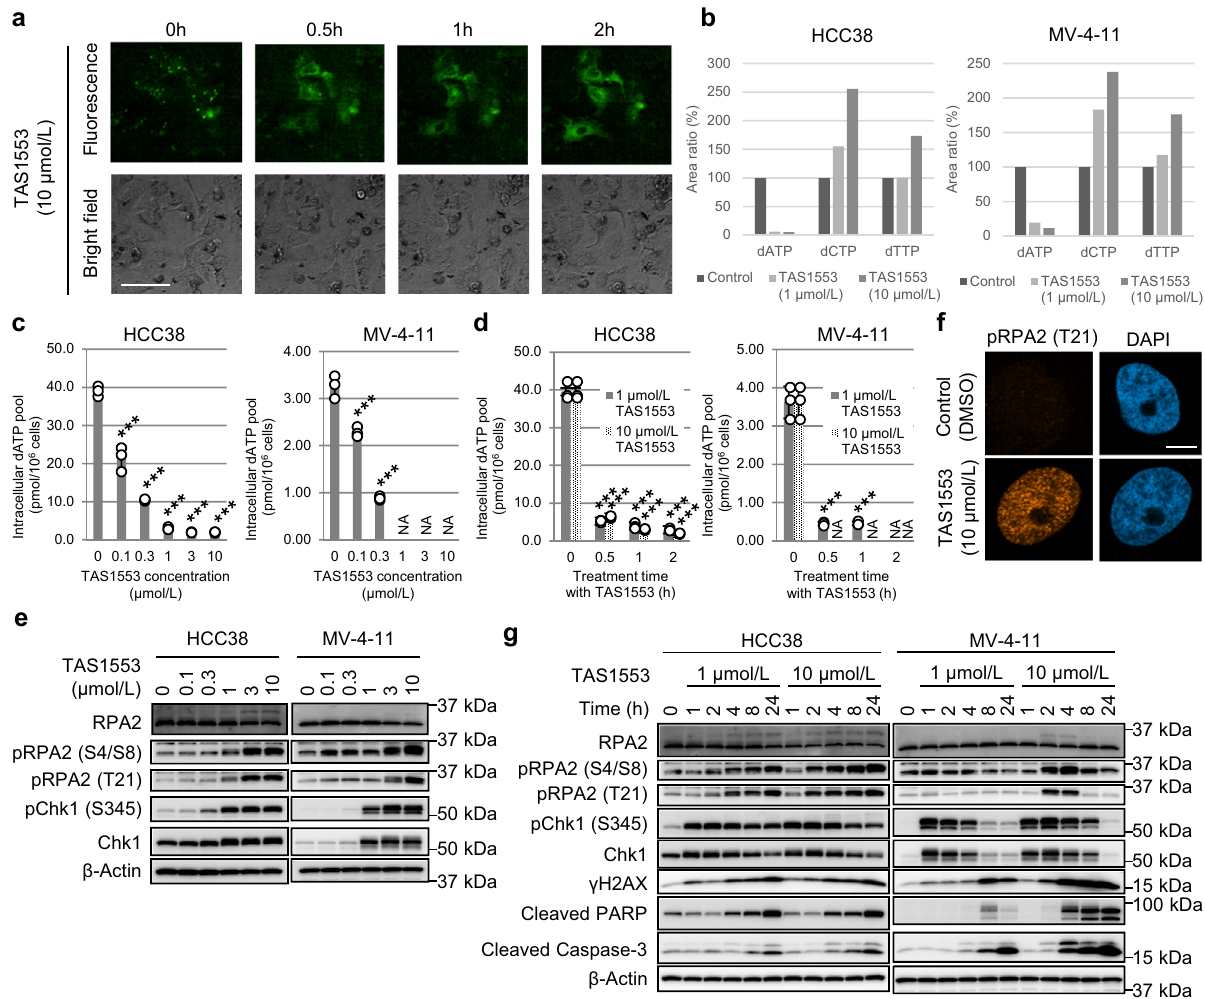
Fig. 2 Effect of TAS1553 on RNR subunit interaction, dNTP pool, DNA replication stress, and apoptosis. a Inhibition of intracellular protein-protein interaction between R1 and R2 by TAS1553. HCC38 cells co-transfected with cDNAs encoding AG-tagged R1 and Ash-tagged R2 were treated with TAS1553 for 2 h, followed by incubation with drug-free medium for 1 h. Fluorescence and bright- fi eld images were obtained at the indicated timepoints. R1- R2 interaction is visible as green dots in fl uorescence images. Scale bar, 100 µ m. b Effect of TAS1553 on intracellular dNTP pool in HCC38 and MV-4-11 cells. Relative changes of dATP, dCTP, and dTTP peak area in HCC38 and MV-4-11 cells treated with TAS1553 for 2 h or DMSO as control. Intracellular metabolites were measured by LC-MS/MS. c Concentration-dependent changes of the dATP pool in HCC38 cells and MV-4-11 cells treated with TAS1553 for 2 h. d Time-dependent changes of the dATP pool in HCC38 cells and MV-4-11 cells treated with TAS1553. Data are presented as the mean ± SD ( N = 3). NA not applicable. *** P < 0.001 versus control (0 µ mol/L or 0 h). e Induction of DNA replication stress and apoptosis by TAS1553 in HCC38 and MV-4-11 cells. Concentration-dependent effect of TAS1553 on DNA replication stress in HCC38 cells and MV-4-11 cells. The cells were incubated with TAS1553 and harvested 2 h post-treatment. The expression of indicated proteins was analyzed by immunoblotting. f Immuno fl uorescence analyses in HCC38 cells treated with TAS1553 at 10 µ mol/L for 2 h. Representative confocal microscopy images; pRPA2 (Thr21) (red) and DAPI (blue). Scale bar, 10 µ m. g Time-dependent effect of TAS1553 on DNA replication stress and apoptosis in HCC38 cells and MV-4-11